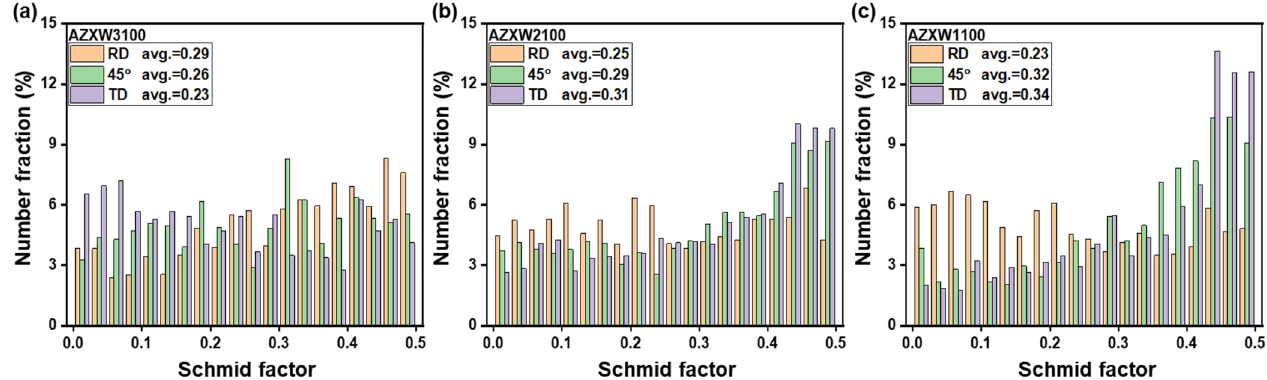
Figure 7. SFs along the RD, 45° direction, and TD: ( a ) AZXW3100, ( b ) AZXW2100, and ( c ) AZXW1100.